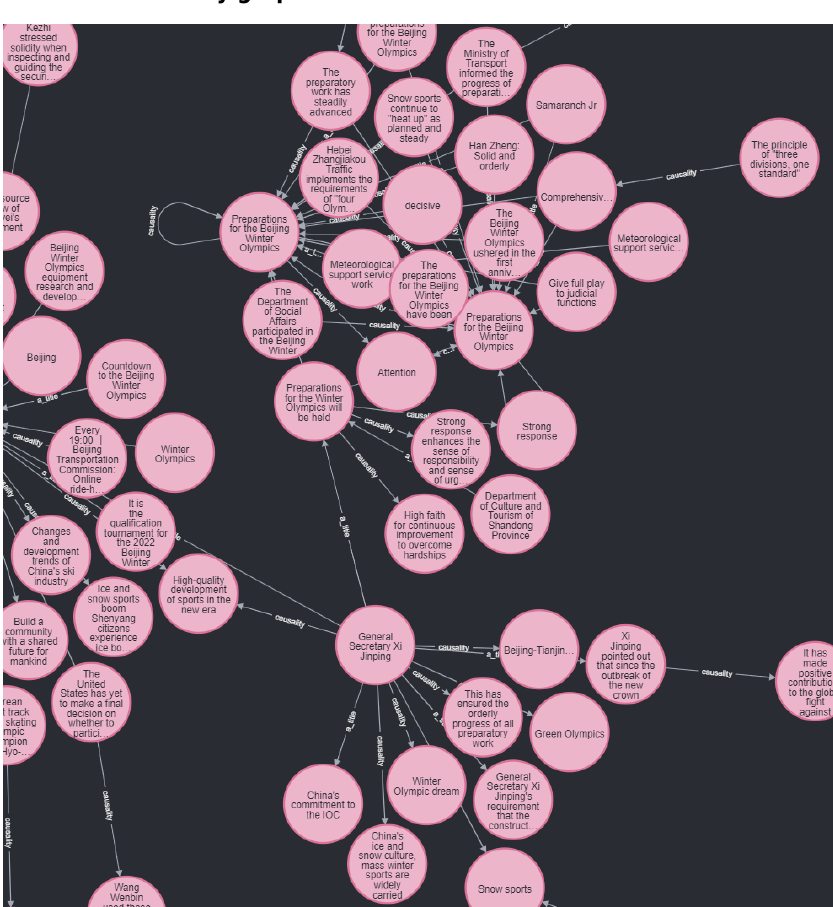
Fig. 6. Partial graph of news coverage from January to